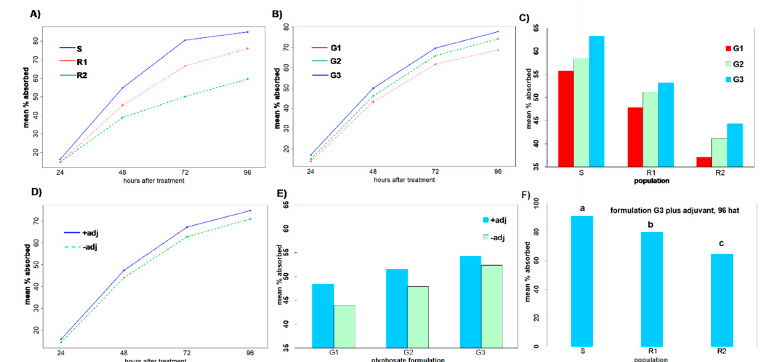
Figure 4. Effect of Hours After Treatment (HAT), C. sumatrensis population, glyphosate formulation and adjuvant treatment on leaf uptake of 14C-glyphosate. Plots of interactions retained in the minimal adequate model based on ANOVA are shown ( A – F ). ( A – C ) interactions involving HAT, population and formulation; ( D – E ) interactions of adjuvant with HAT and with formulation; ( F ) glyphosate uptake at 96 HAT using formulation G3 with adjuvant added, according to population. Different letters in F indicate significant differences according to a Kruskal–Wallis test followed by pairwise comparisons using the Wilcoxon test with Bonferroni correction for multiple testing. For adjuvant type: + adj, adjuvant added, either adj1 or adj2; -adj, without adjuvant.